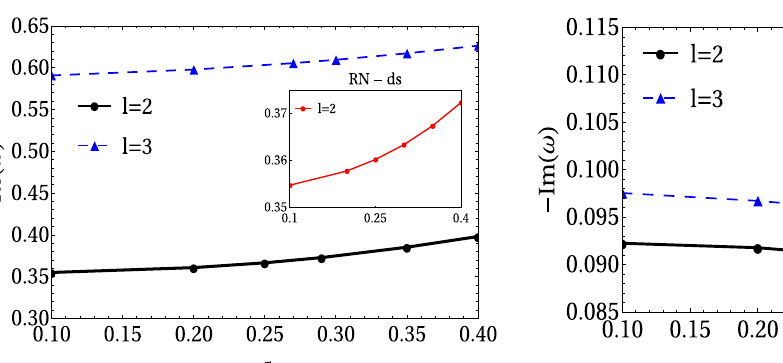
Fig. 8 Q-factor vs parameters (cid:2) and q